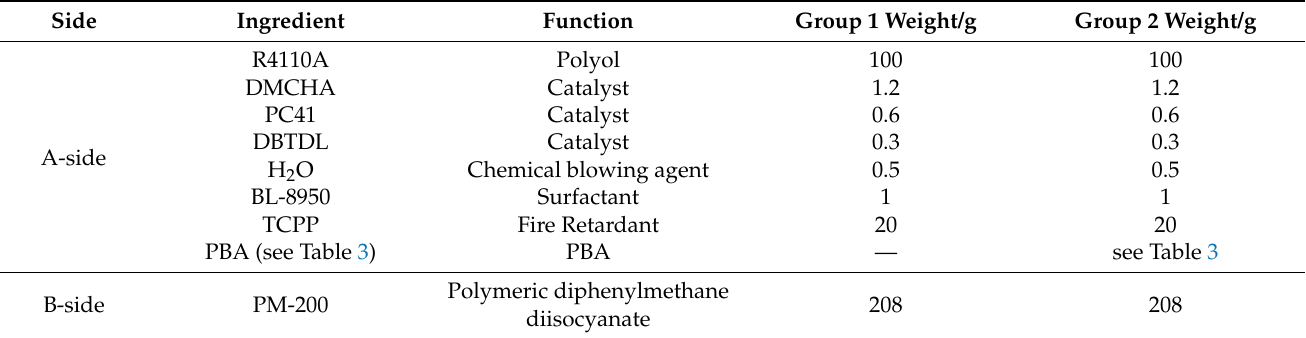
Table 2. Recipes for Group 1 and Group 2 foaming.